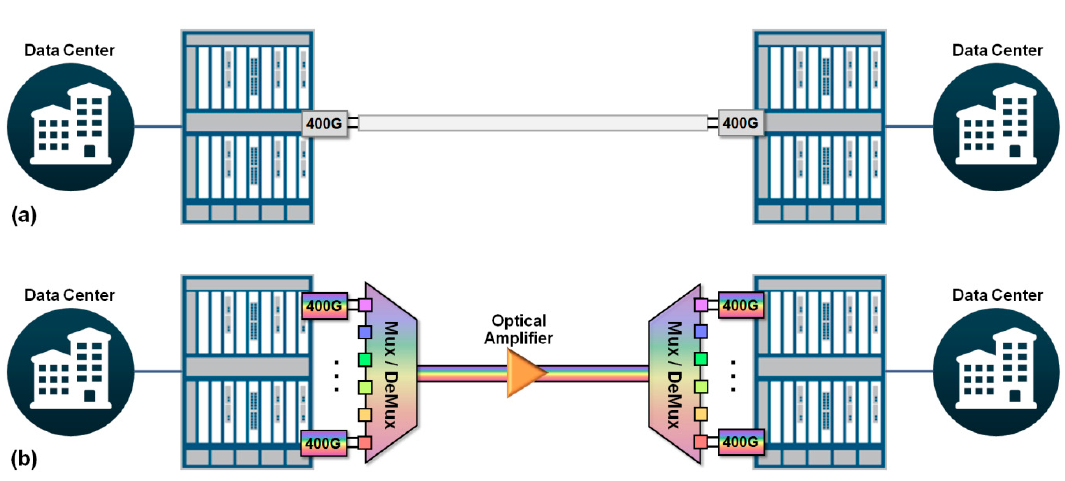
Figure 1. Typical application scenarios of 400 Gb/s pluggable optics for data center interconnect. ( a ) Unamplified point-to-point applications for 40 km reach; ( b ) amplified dense wavelength division multiplexing (DWDM) applications for 80–120 km reach.